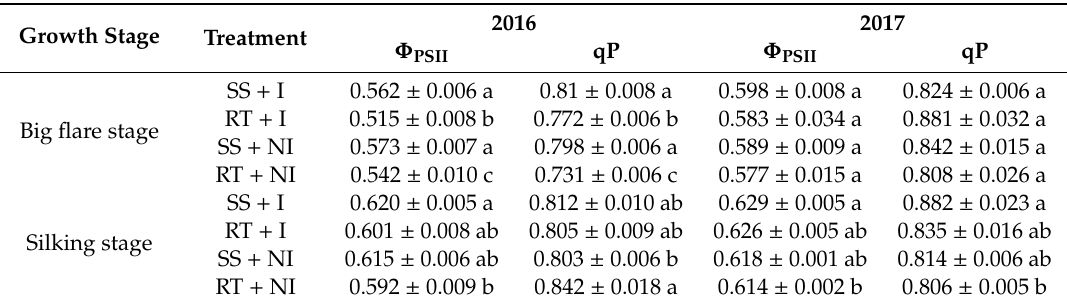
Figure 3. E ff ects of di ff erent tillage practices on the Fv / Fm and Fv / Fo of summer maize at di ff erent Figure 3. Effects of different tillage practices on the F v / F m and F v / F o of summer maize at different growth stages. Di ff erent small letters under the same growth stage indicate significant di ff erences growth stages. Different small letters under the same growth stage indicate significant differences between tillage practices. between tillage practices. Table 5. E ff ects of di ff erent tillage practices on the Φ PSII and qP of summer maize at di ff erent Table 5. Effects of different tillage practices on the Ф PSII and qP of summer maize at different growth growth stages.